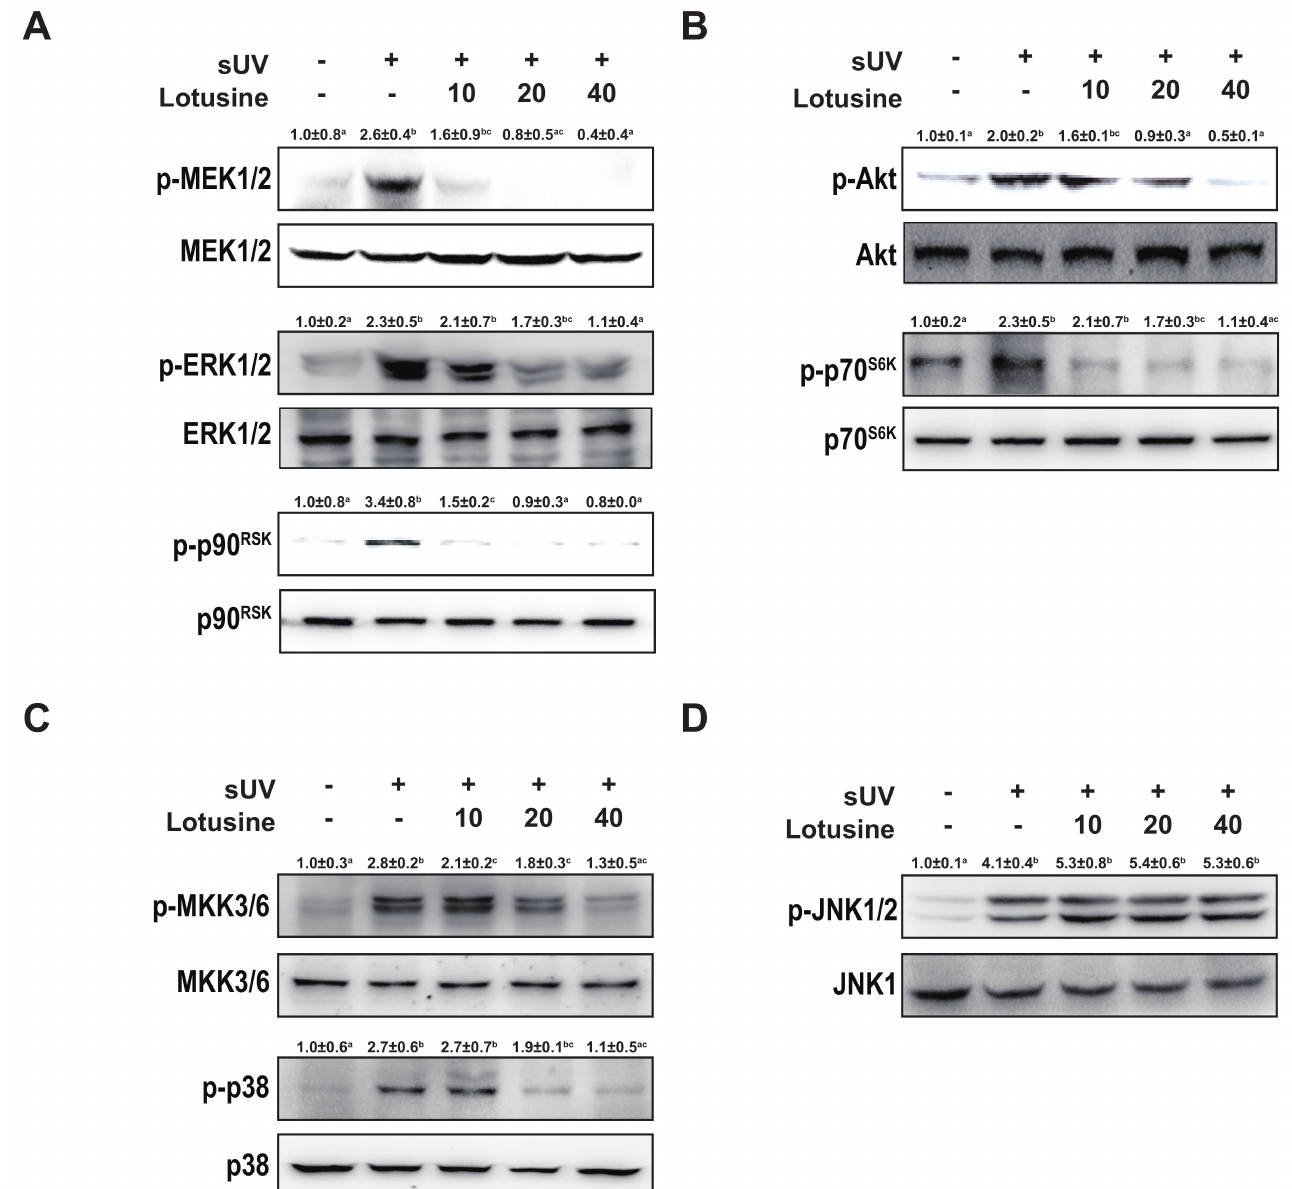
Figure 4. Lotusine suppresses solar ultraviolet (sUV)-induced MEK1/2-ERK1/2-p90 RSK , MKK3/6-p38, and Akt-p70 S6K pathways in HaCaT cells. ( A ) and ( B ) Effect of lotusine on sUV- induced phosphorylation of the MEK1/2-ERK1/2-p90 RSK and Akt-p70 S6K signaling pathway. ( C ) and ( D ) Effect of lotusine on sUV-induced phosphorylation of the MKK3/6-p38 and JNK1/2 signaling pathways. Phosphorylation and total protein levels were analyzed by Western blotting. Relative band strength is indicated by the folding of the control and at the top of each band using Image Studio software (LI-COR). Different letters (a–d) significantly differ ( p < 0.05) according to Duncan’s multiple range